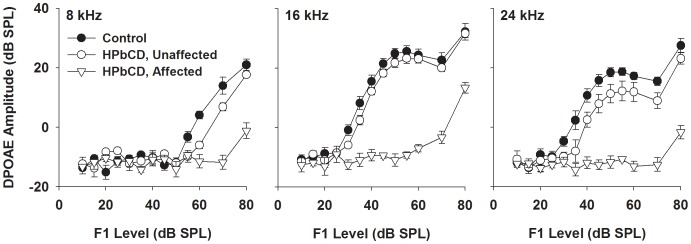
DPOAE responses are decreased one week after treatment with 8,000 mg/kg HPβCD.Treated animals were broken into two groups according to whether their ABR thresholds were affected by HPβCD. DPOAE amplitude is plotted against the F1 stimulus level for each of the three test frequency pairs with geometric means of 8, 16, and 24 kHz. Error bars represent one standard error of the mean.